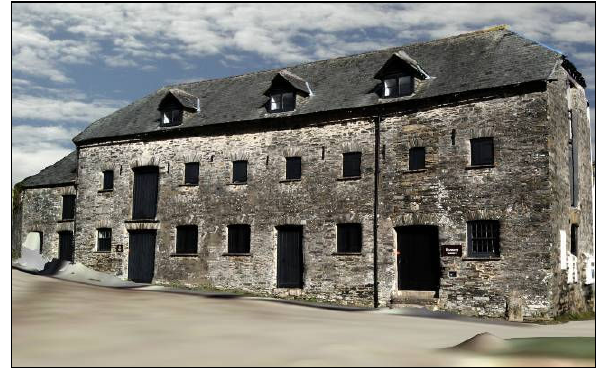
Figure 4 A rendered image of the Discovery Centre, Cotehel Quay, 3DS Max